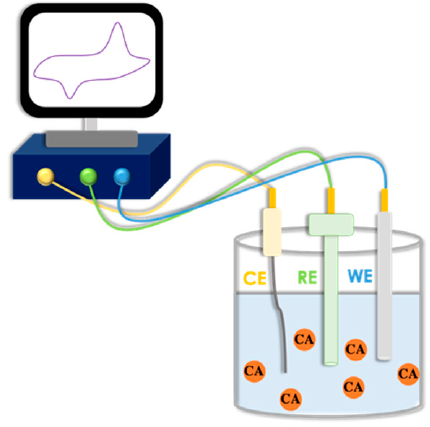
Figure 12. Experimental setup for CV measurements.